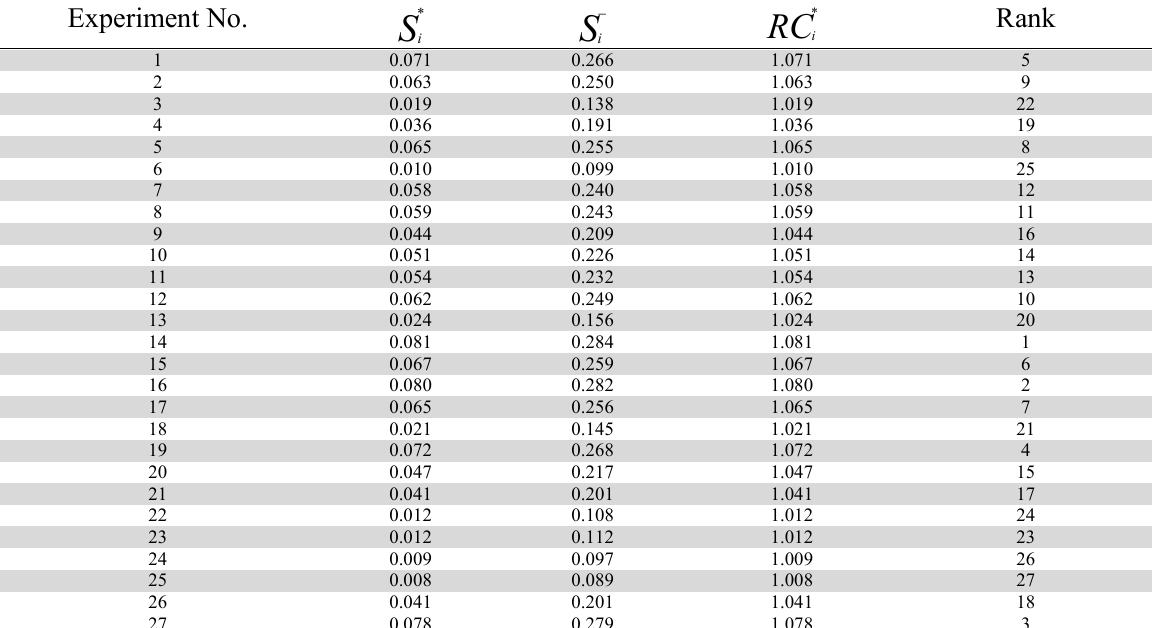
Closeness coefficient values and ranking of alternatives Experiment